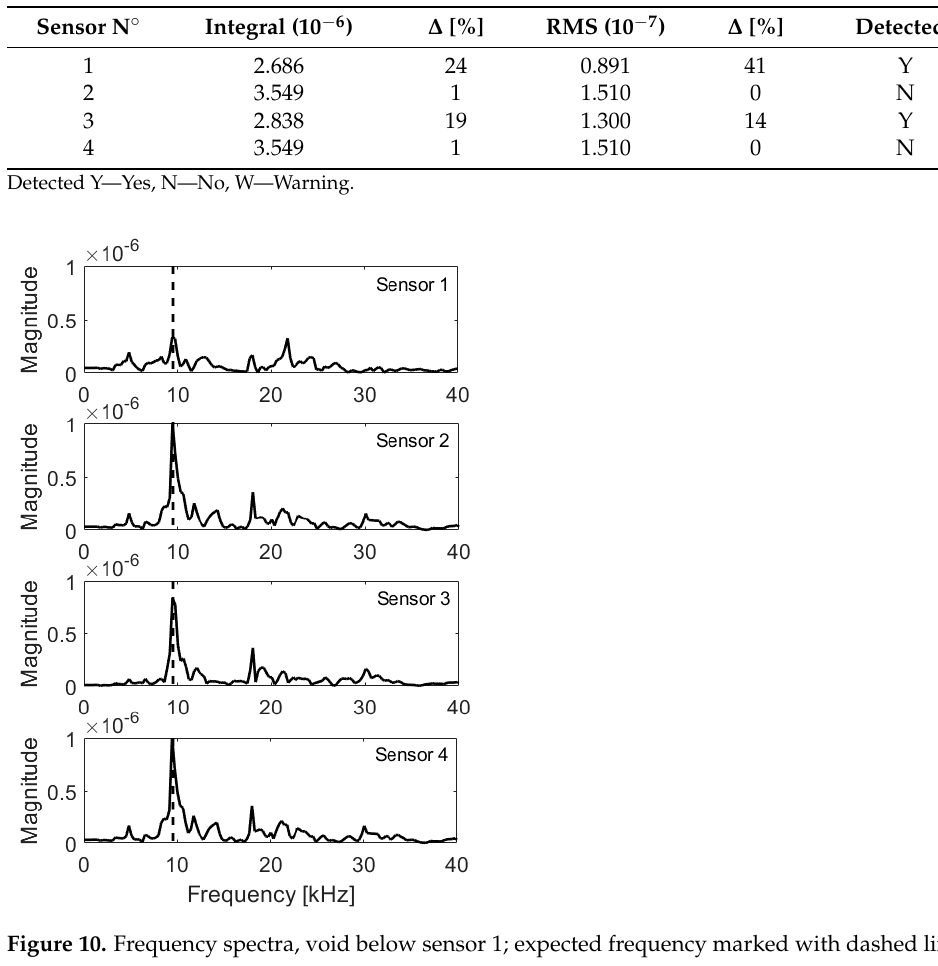
Figure 10. Frequency spectra, void below sensor 1; expected frequency marked with dashed line.